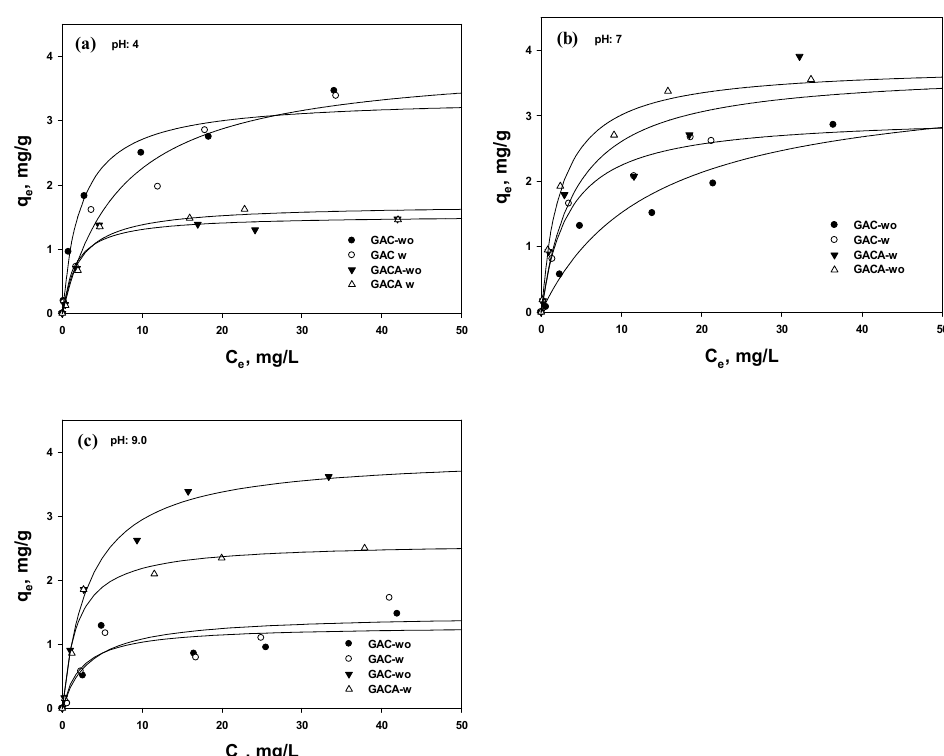
Figure 4. Langmuir isotherm for GAC and GACA with/without pH adjustment at initial pH of 4 ( a ), 7 ( b ), and 9 ( c ).